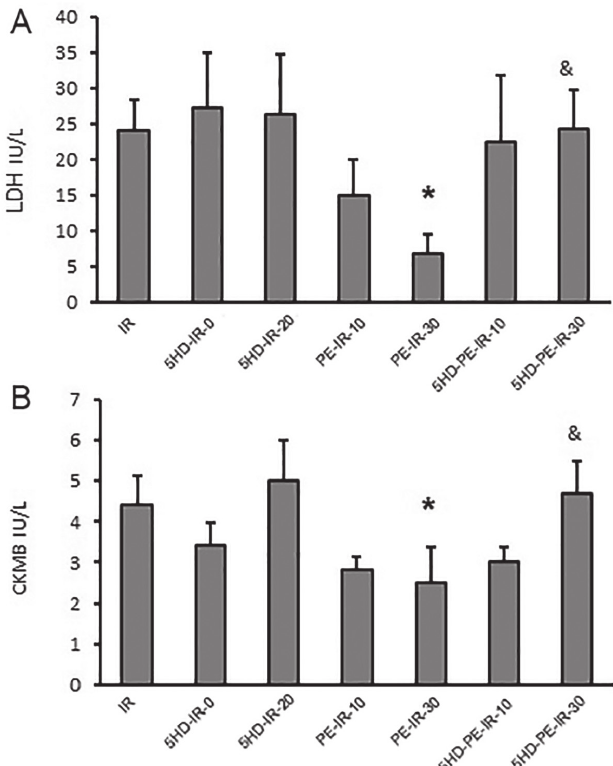
FIGURE 4 - A - Level of LDH and B - CK-MB in coronary effluent in 60 min after reperfusion in ischemia/reperfusion (IR), 5HD perfused at onset of regional ischemia (5HD-IR-0), 5HD perfused 20 min after regional ischemia (5HD-IR-20), phenylephrine-early perconditioning 10 min after ischemia (PE-IR-10), phenylephrine-late perconditioning 30 min after ischemia (PE-IR-30), 5HD-phenylephrine Early perconditioning (5HD-PE-IR-10), 5HD-phenylephrine-late perconditioning (5HD-PE-IR-30) groups. Data are presented as mean±SEM. Significant difference with IR group (P<0.05) * . Significant difference with PE-IR-30 group (P<0.05) &